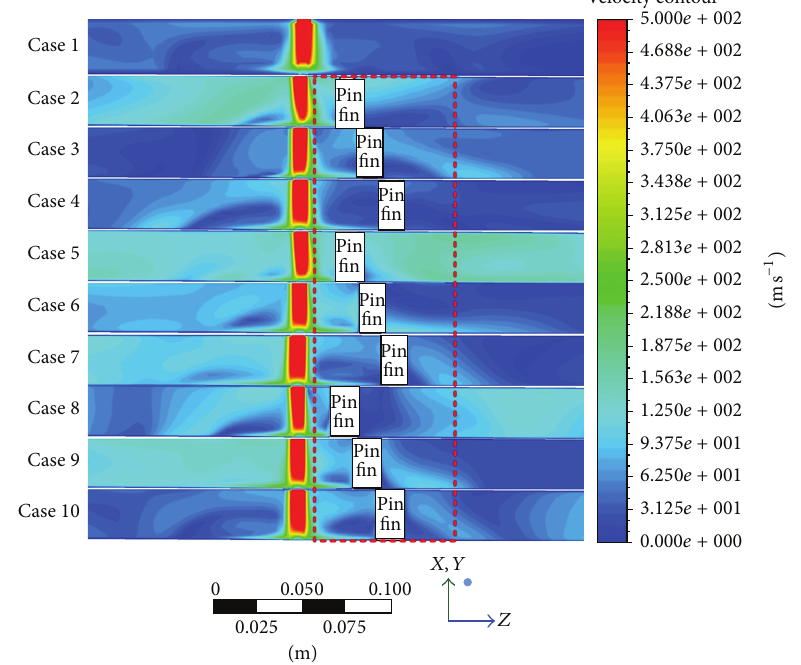
Figure 3: Contours of velocity.